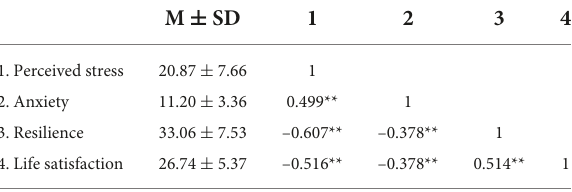
TABLE 2 Bivariate correlation among perceived stress, anxiety, resilience, and life satisfaction ( n =